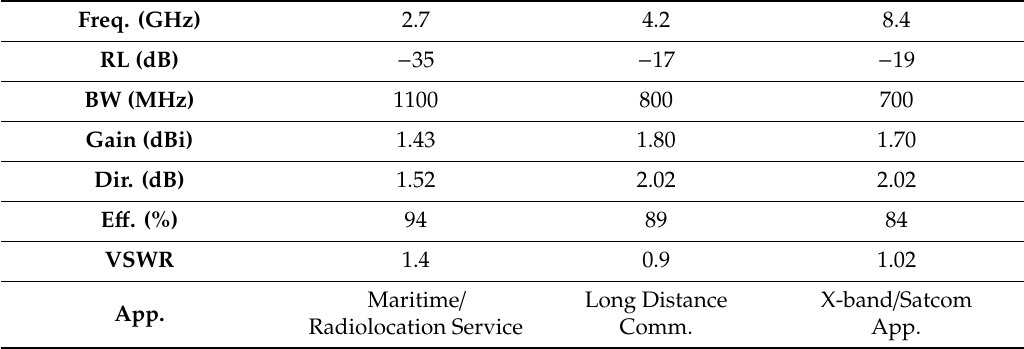
Table 6. Summarized results of Case 4.